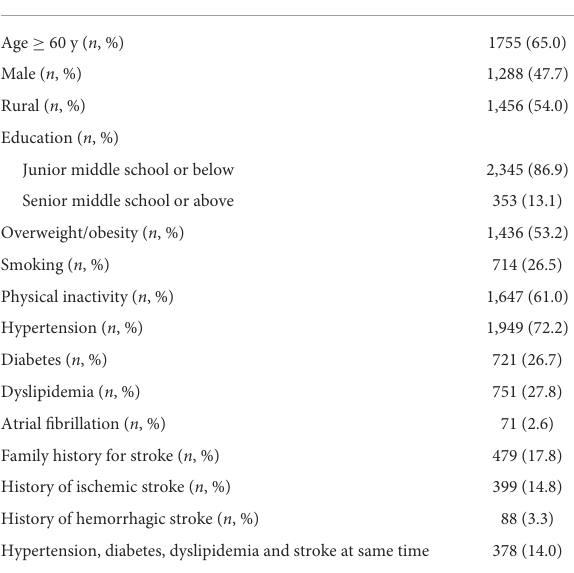
TABLE 1 Baseline characteristics of the 2,698 high-risk stroke population at a face-to-face survey. Characteristics N = 2,698